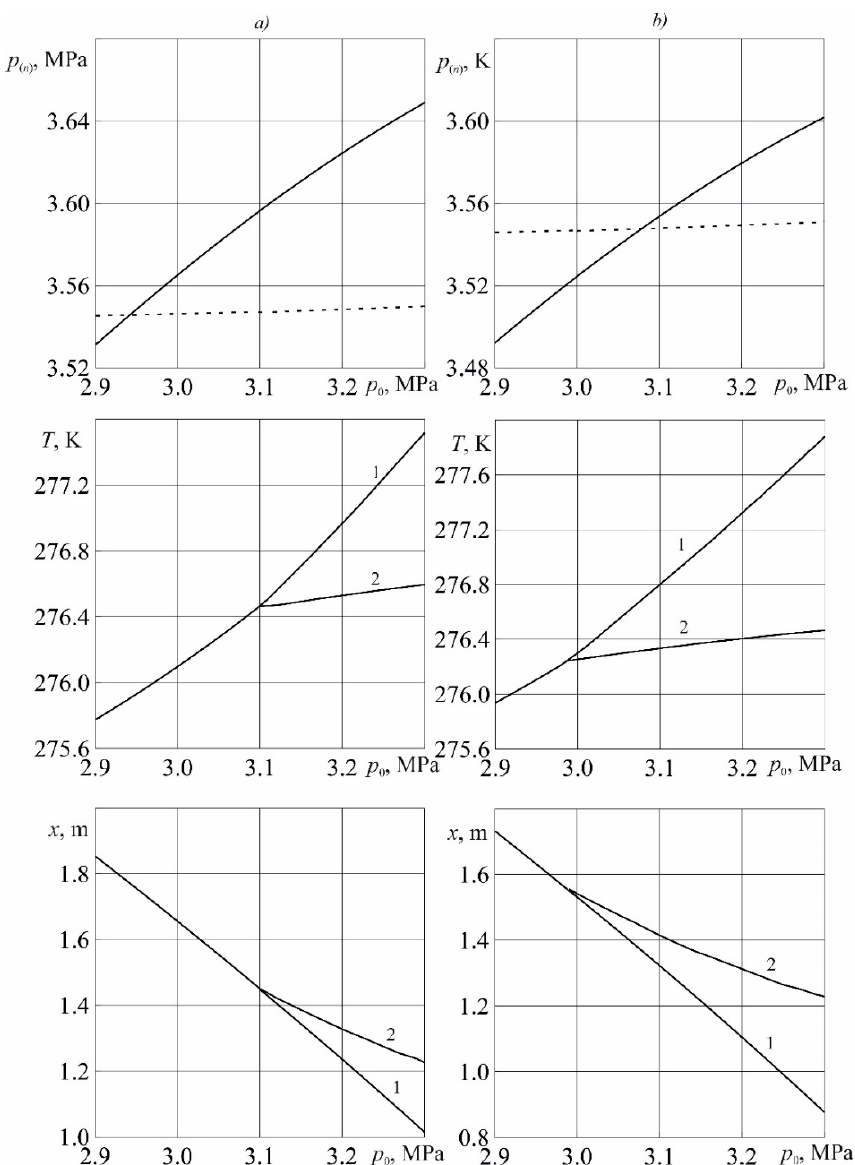
Figure 5. Dependencies of pressure values, temperatures and coordinates of phase transition boundaries on pressure at the right reservoir boundary. p е = 3.7 MPa ( a ) and 3.64 MPa ( b ).